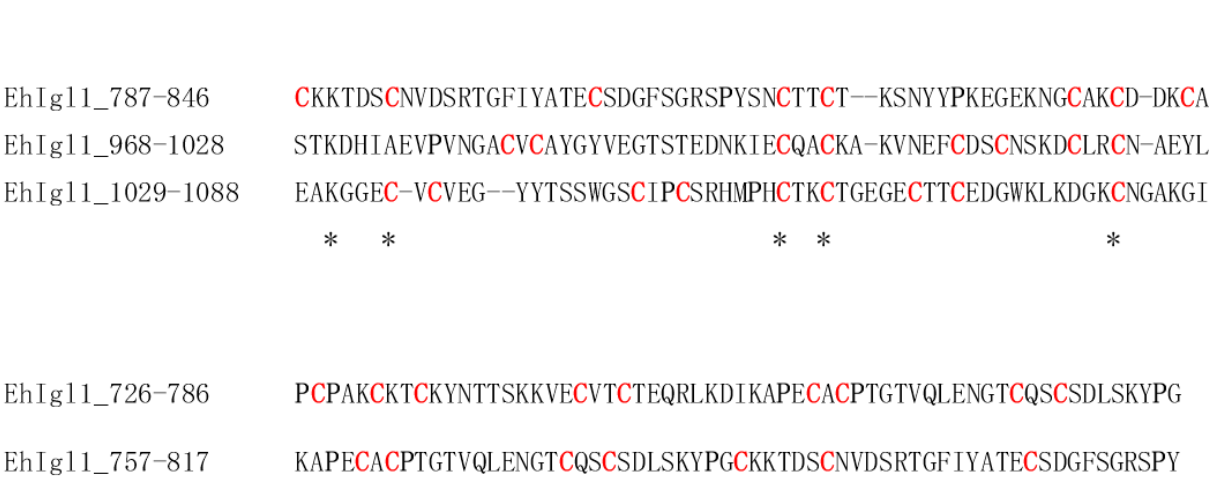
Figure 5. Hemolytic and cytotoxic regions of Igl1. ( A ) The Igl1 14-1088 recombinant fragment lacks the signal sequence (aa 1–13) and GPI-anchored domain (aa 1089–1101). Regions in red are those with both hemolytic and cytotoxic activities. ( B ) Schematic of Hgl, Lgl and Igl on the cell membrane of E. histolytica . Igl is associated with other lectin subunits: Hgl and Lgl. CRD: carbohydrate recognition domain.